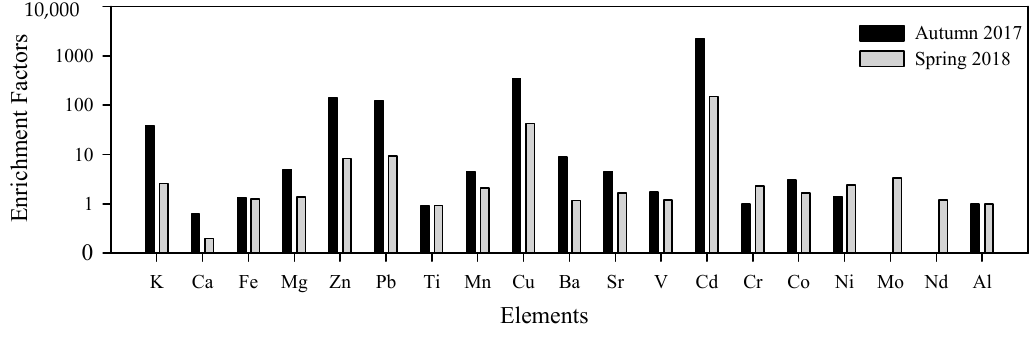
Figure 6. Enrichment factors in PM 2.5.